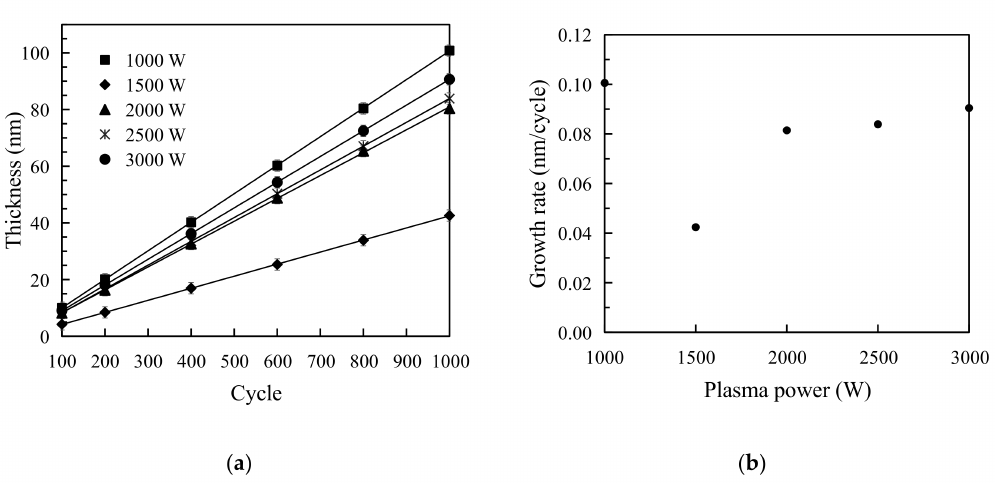
Figure 3. ( a ) Increase in the thickness of SiO 2 thin films with the number of RP-ALD cycles; ( b ) deposition rate of the RP-ALD SiO 2 thin films prepared at different plasma